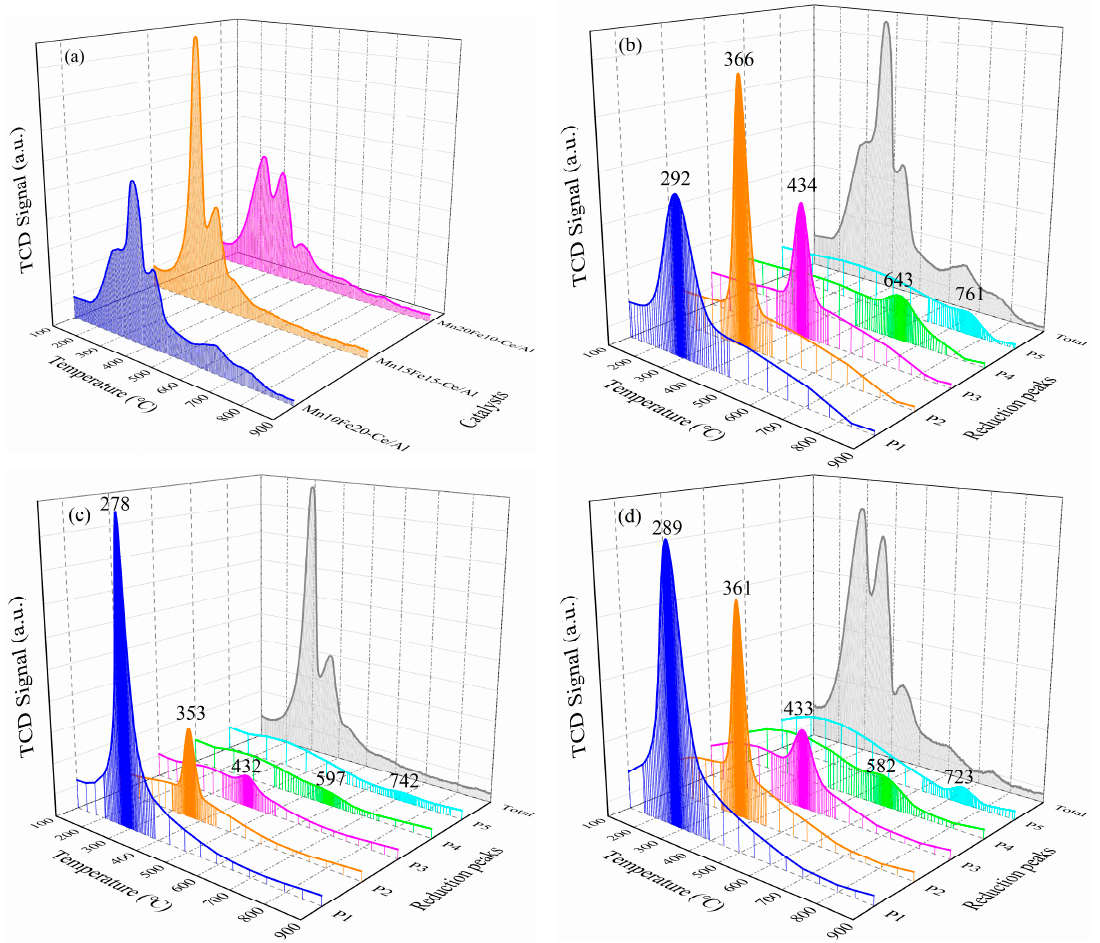
Figure 4. H 2 ‐ temperature ‐ programmed reduction (H 2 ‐ TPR) pro fi les of Mn − Fe − Ce − O x / γ‐ Al 2 O 3 Figure 4. H 2 -temperature-programmed reduction (H 2 -TPR) profiles of Mn nanocatalysts: ( a ) total H 2 -TPR curves; ( b ) multi-peak Gaussian fitting for Mn10Fe20 − Ce/Al